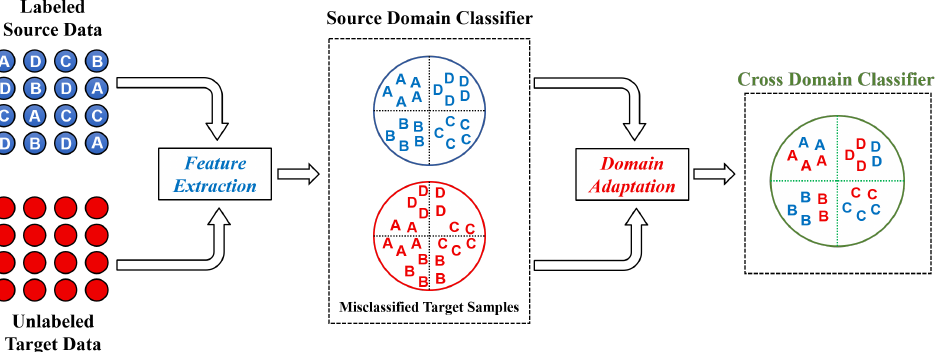
Figure 1. The schematic representation of domain adaptation